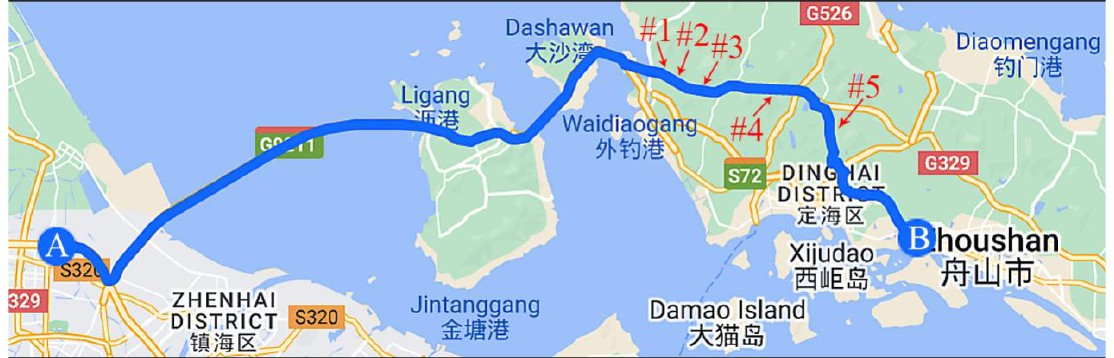
Figure 7. The vehicle trajectory in Experiment 2.